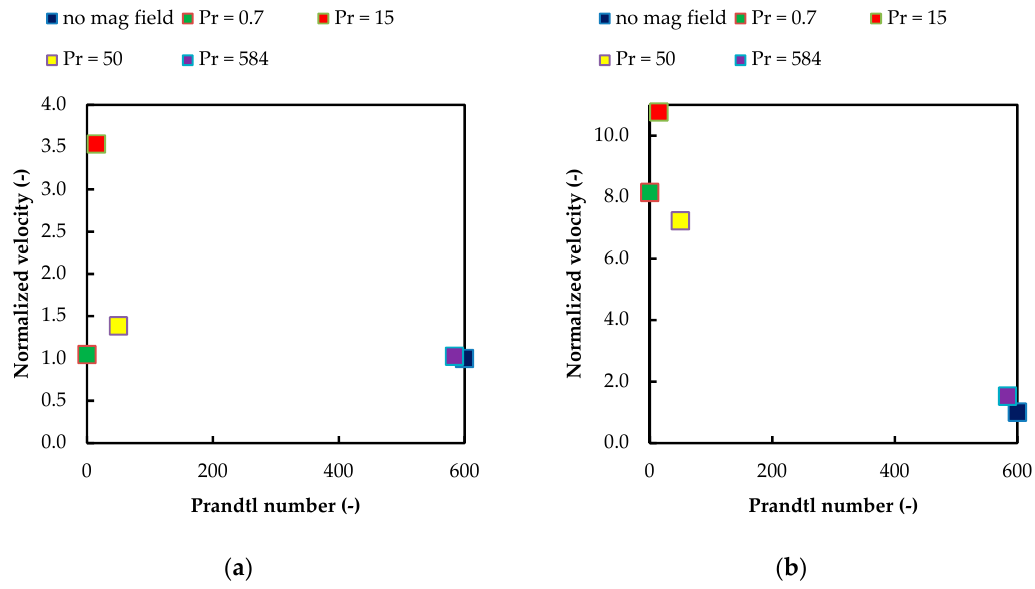
Figure 17. Maximal flow velocities values versus the Prandtl number value: ( a ) Re = 1, b 0 = 5 T, ( b ) Re = 1, b 0 = 10 T.